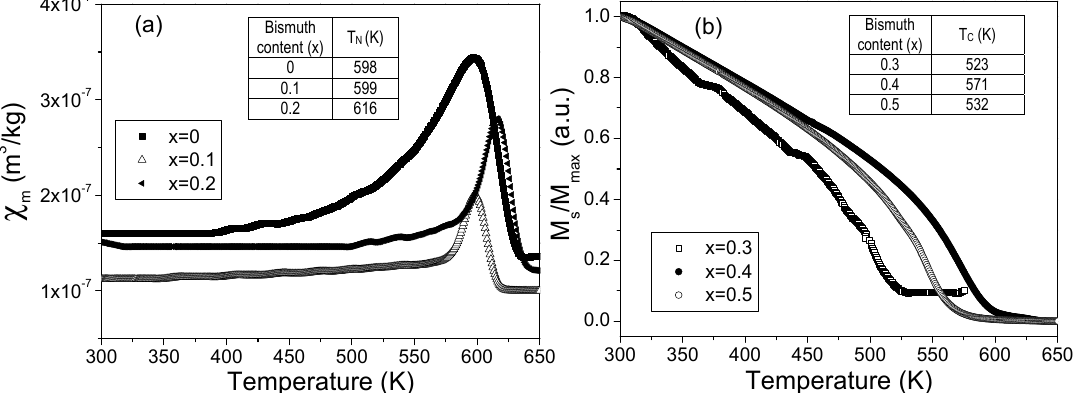
Figure 4. ( a ) Temperature dependence of magnetic susceptibility and, ( b ) magnetization of Y 1-x Bi x FeO 3 (0 ≤ x ≤ 0.5, Δ x = 0.1) pressed and sinteredat 700 ° C.